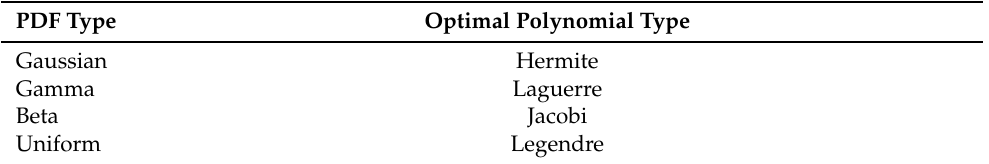
Table 3. The type of PDFs and the corresponding orthogonal